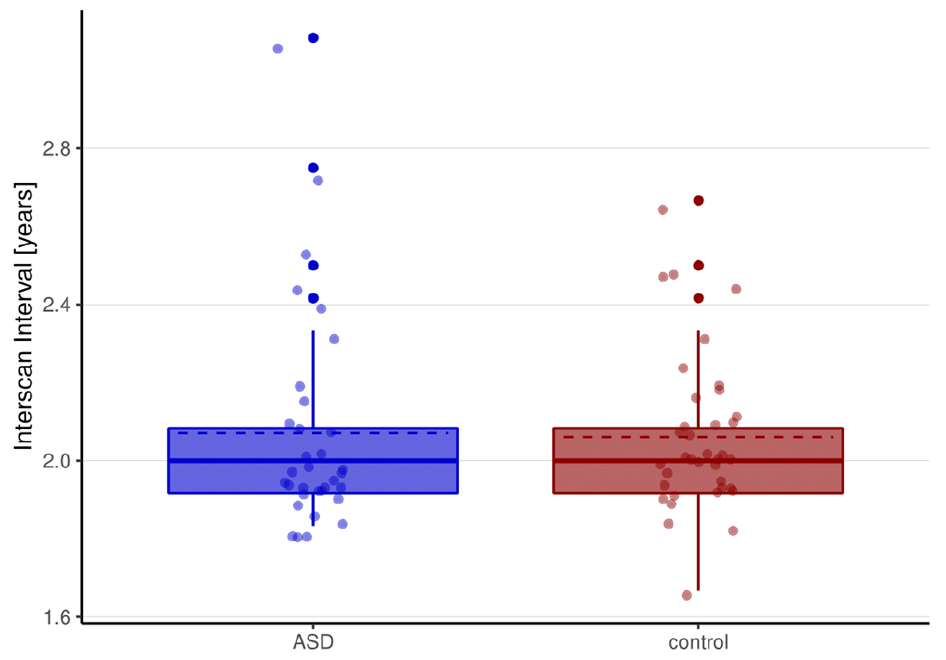
Figure 1. Interscan Interval (ISI) of the ASD and control group. Time between the two scanning timepoints in the ASD group (blue) and the control group (red). Dashed lines represent mean scores of ISI, solid lines represent the median scores of